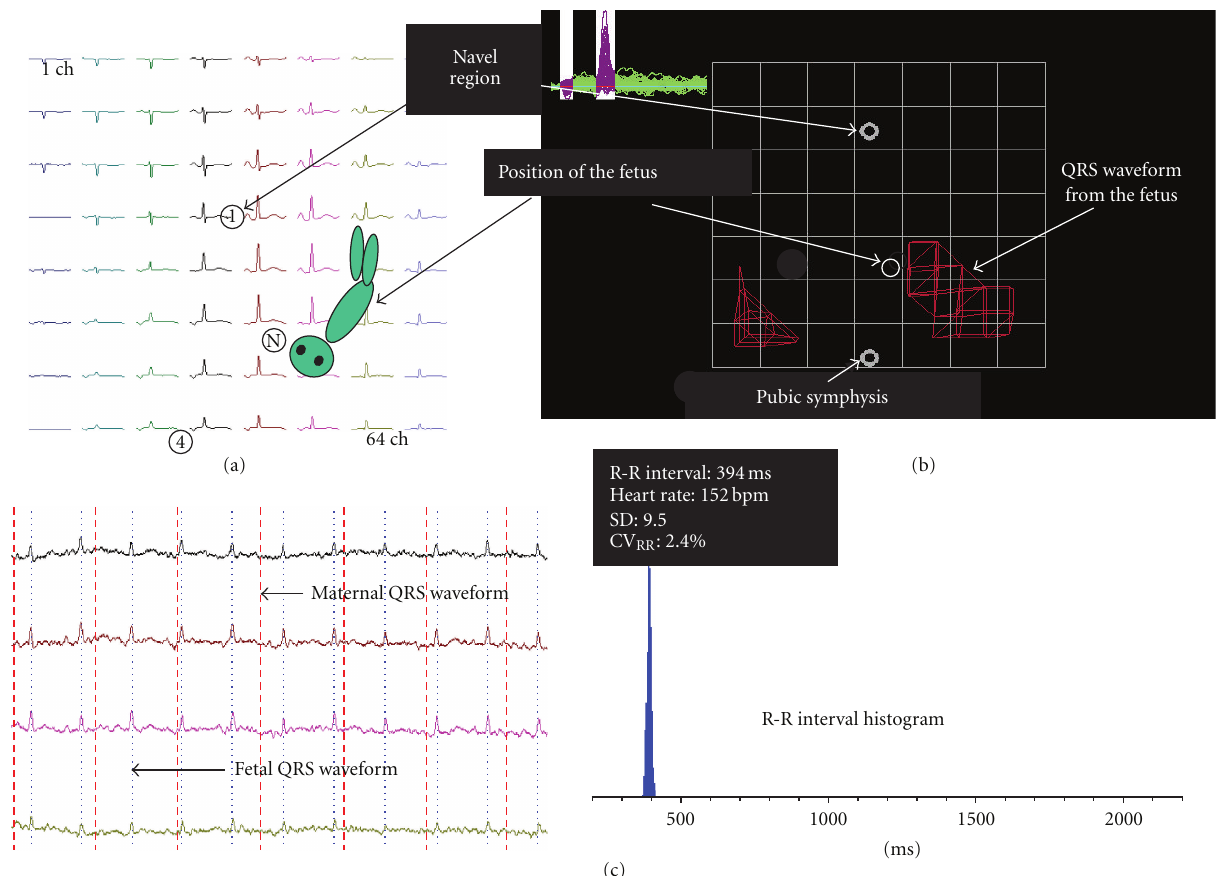
Figure 2: Method of fetal magnetocardiography (FMCG). The position of the fetus was referenced using standard coordinates at the navel region and pubic symphysis (a). Detected magnetic field signals, which comprised signals derived from both the mother and fetus, were subtracted from the maternally derived QRS waveform (b). In performing FMCG, a total of 300–500 heartbeats detected per determination were summated to yield the mean (c).